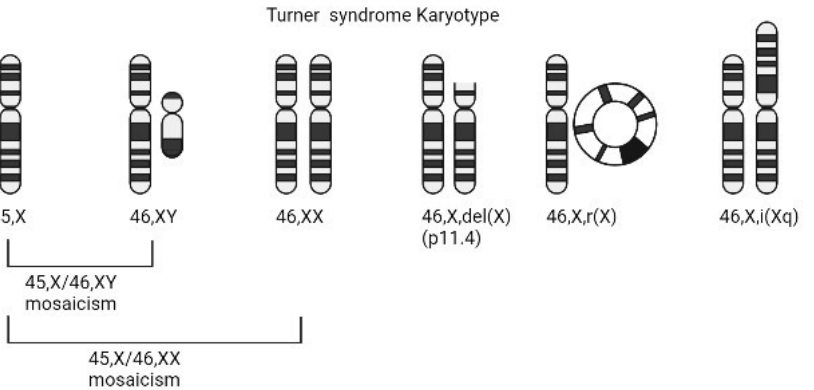
Figure 1. Common Turner syndrome sex chromosome karyotypes with complete or partial loss of genetic material on the second sex chromosome. The ideograms, left to right, represent: monosomy X, mosaicism, X short arm deletion, ring chromosome X, and isochromosome X as the most common karyotypes in Turner syndrome. 45,X/46,XY mosaicism may involve a structurally abnormal Y chromosome.